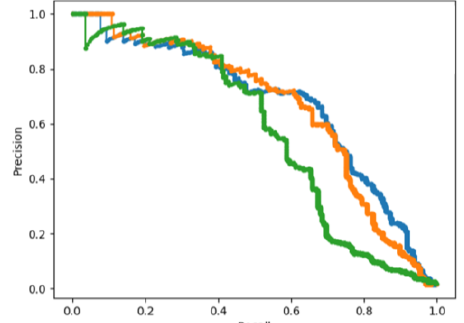
Figure 7. Precision-Recall curves for the 3 main experiments (baseline-blue, oversampling-orange and w100-green) considering all the validation data (from both the beach and